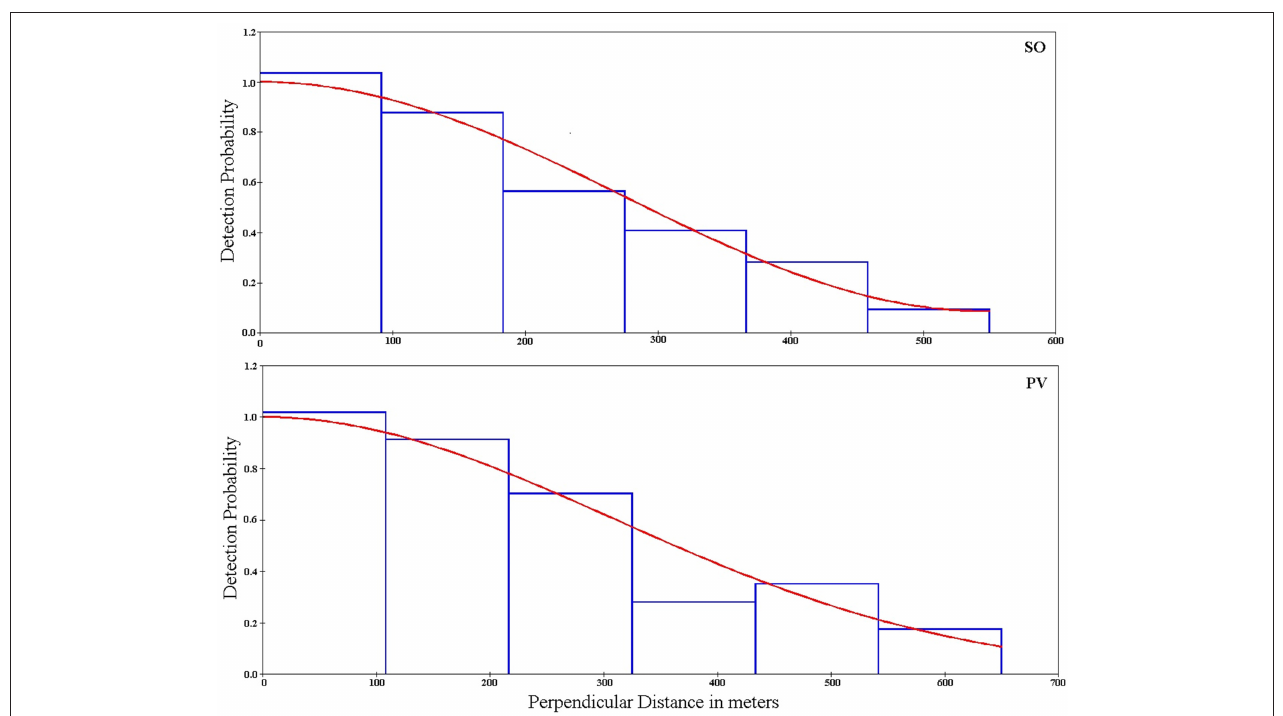
FIGURE 3 | Probability of detection as a function to the distance to the survey line for Somuncura (SO) and Península Valdés (PV). Bars represent grouped data of lesser-rhea groups observed, while the lines represent the fitted, monotonically decreasing functions (Uniform and Half-normal for SO and PV respectively).